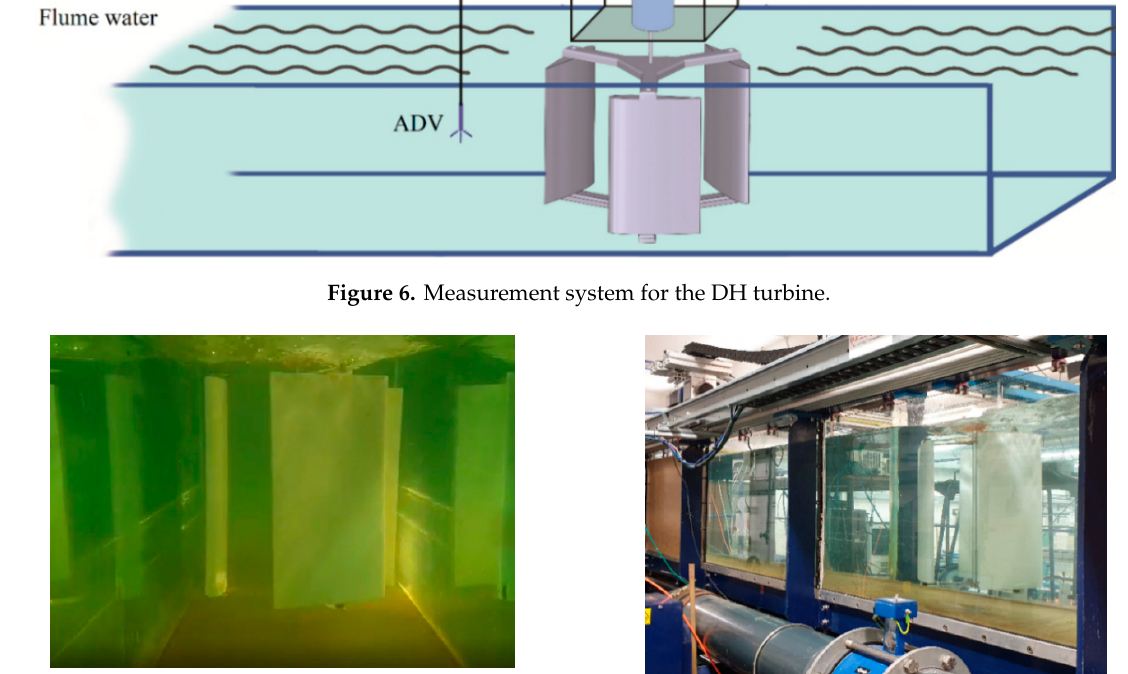
Figure 7. Experiments in hydraulic laboratory of University of Exeter.